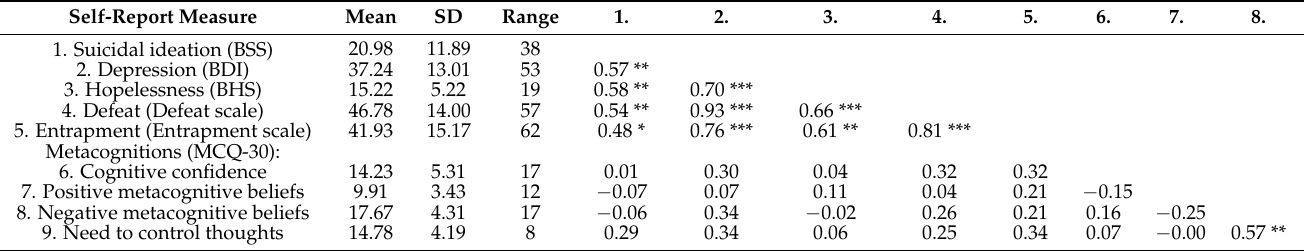
Table 3. Descriptive statistics and Spearman’s correlation coefficients for trait level self-report questionnaire measures ( n = 27). Self-Report